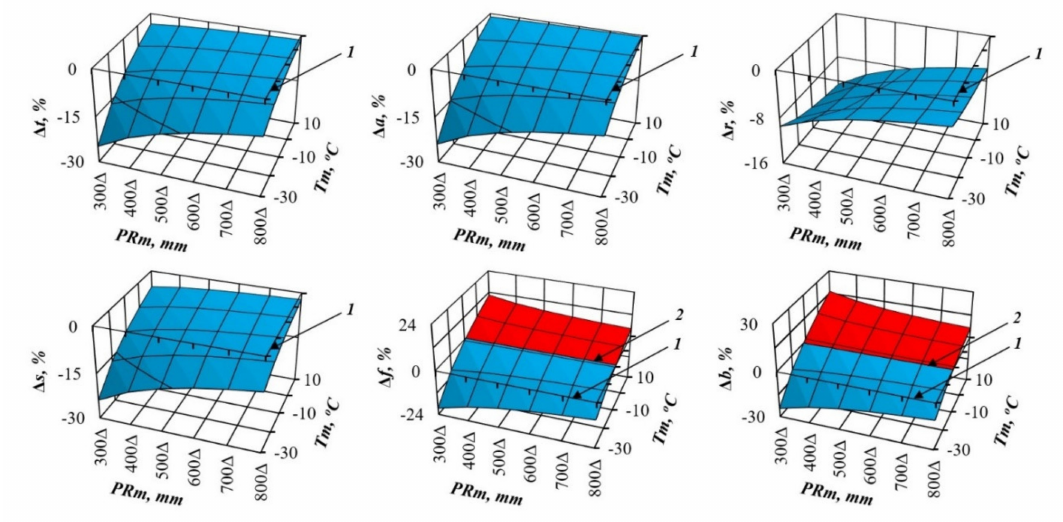
Figure 5. The theoretical changes in pine biomass in relation to the assumed rainfall of 100 mm based on the model (1) for the stands aged 100 years.